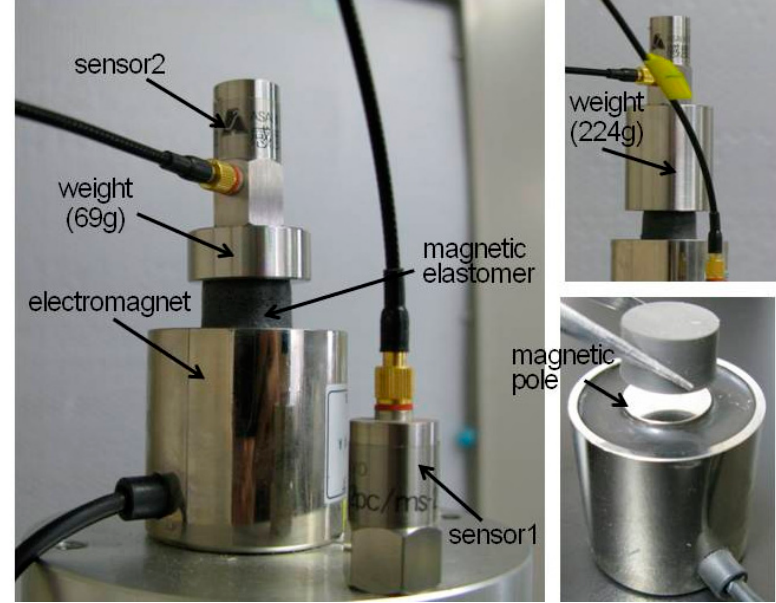
Figure 1. Photographs of the experimental set-up for the vibration measurements for polyurethane and magnetic elastomers under magnetic fields.